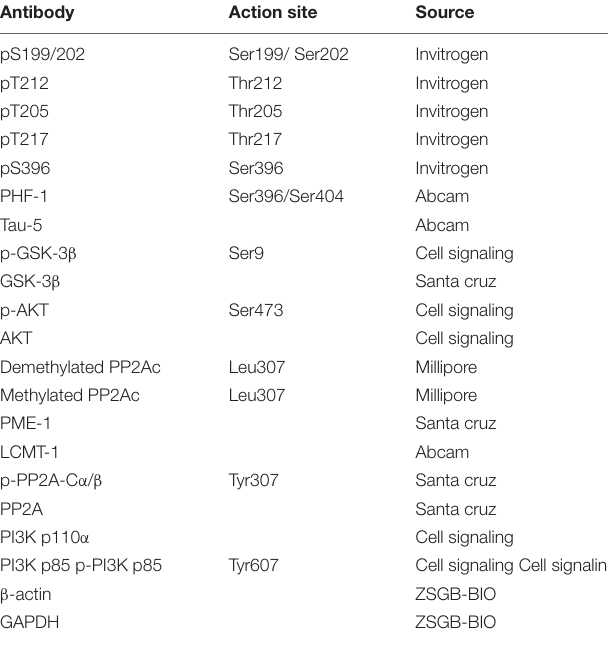
TABLE 1 | Primary antibodies used in this